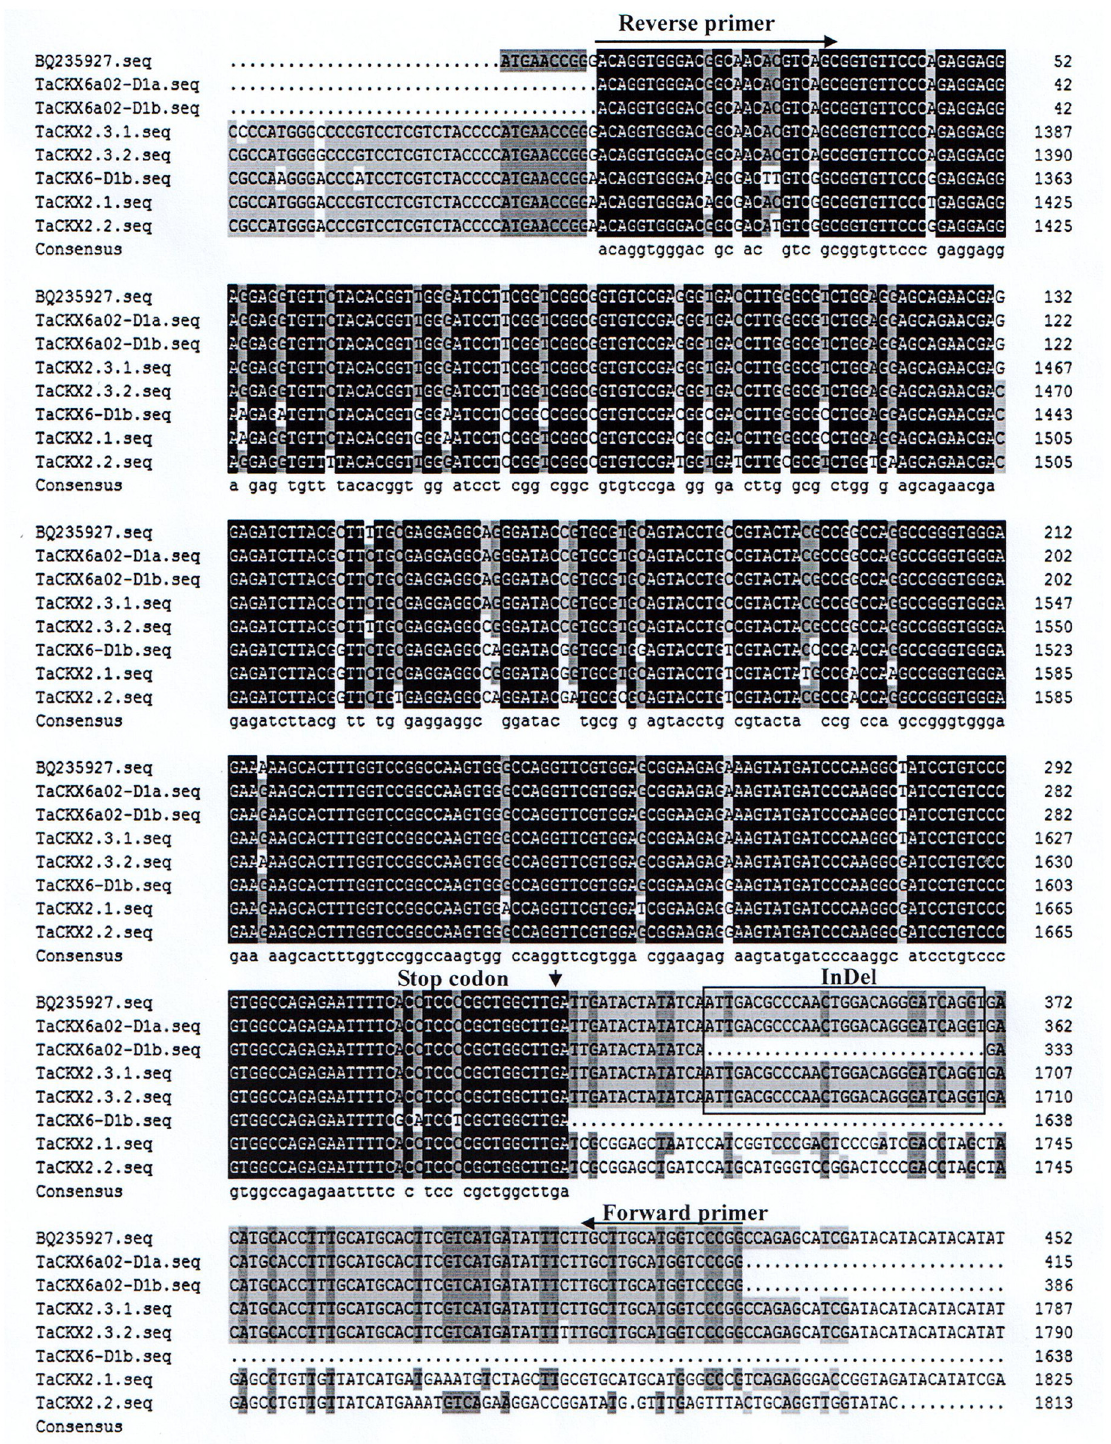
Fig 3. Sequence alignment between TaCKX6a02 and TaCKX2 . 1 , TaCKX2 . 2 , TaCKX2 . 3 . 1 , TaCKX2 . 3 . 2 , and TaCKX6-D1b . Two alleles sequences of Tackx6a02 , TaCKX6a02-D1a ) and TaCKX6a02-D1b were obtained from the reverse-complement sequences of PCR fragments of Jing 411 and Hongmangchun 21. The primer pair and stop codon are marked with arrows in the figure. The InDel sequence is boxed.